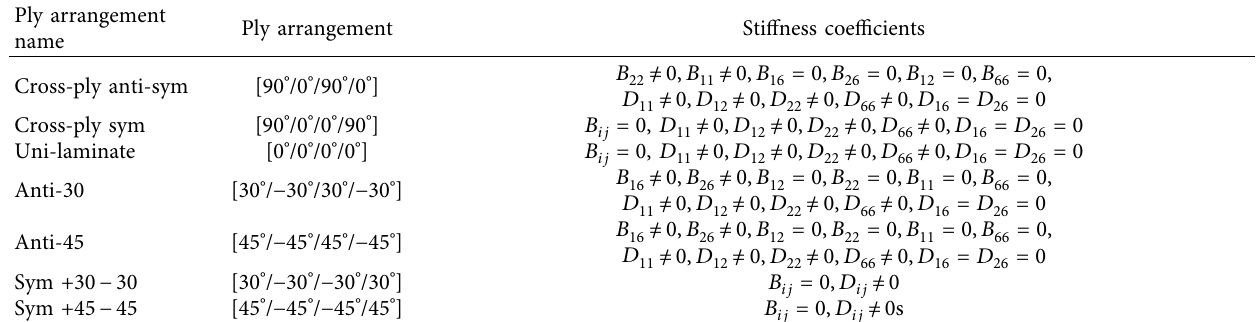
Table 2: Summary of the ply arrangement